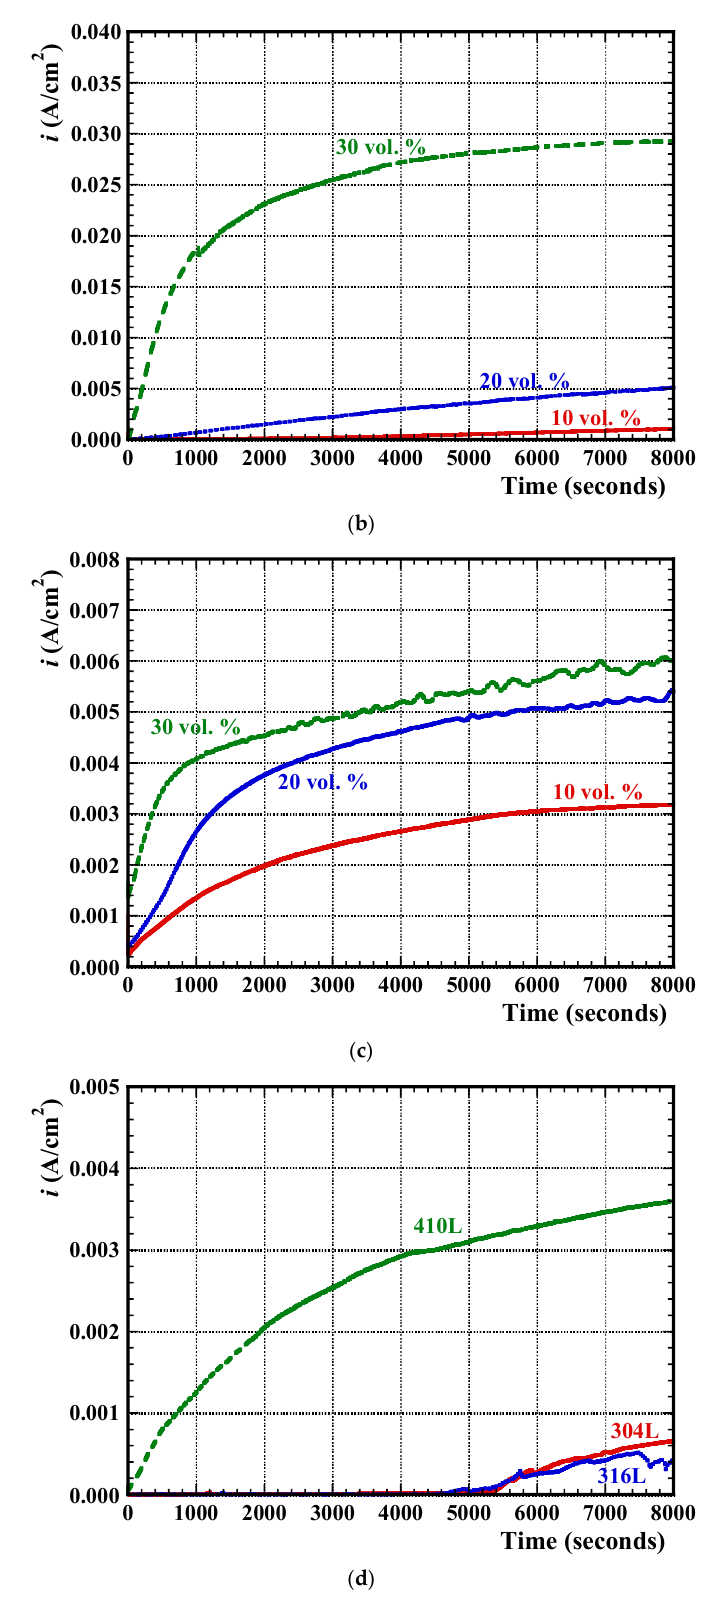
Figure 6. Representative potentiostatic polarisation curves, demonstrating the effects of binder content for each of the TiC–stainless steel cermets, together with comparison of the “pure” stainless steels: ( a ) TiC-304L; ( b ) TiC-316L; ( c ) TiC-410L; and ( d ) the baseline stainless steels.